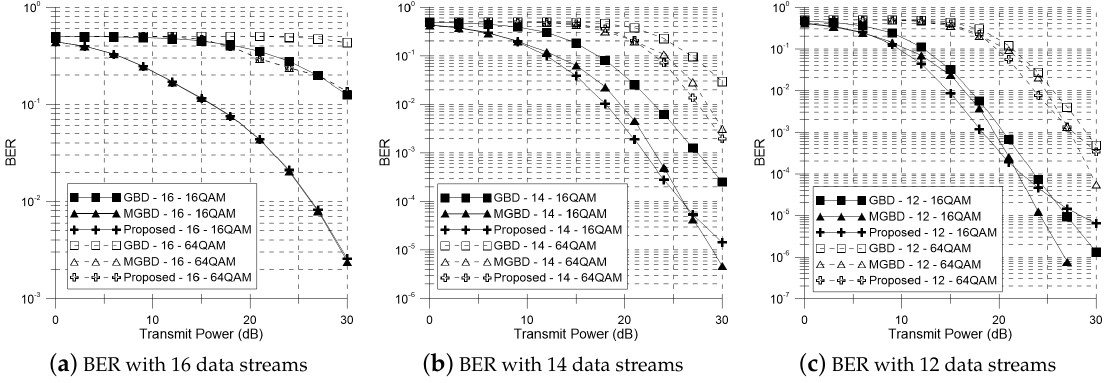
Figure 7. BER performance of GBD, MGBD and proposed scheme with N T = N R = 16.